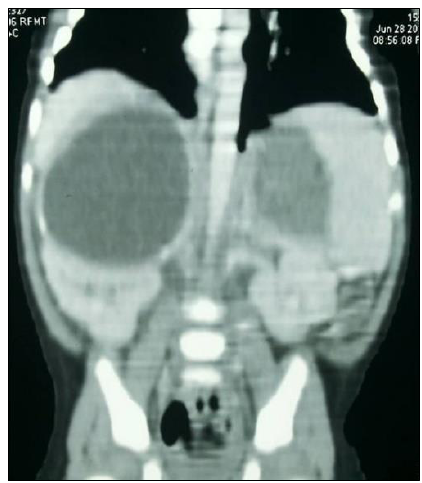
Figure 2: Case 2, Abdominal computed tomography image (coronal section) showing encysted collections with enhancing rims with fine internal septations in bilateral suprarenal areas, measuring 6.8 × 4.6 cm on the right side and 2.5 × 1.8 cm on the left